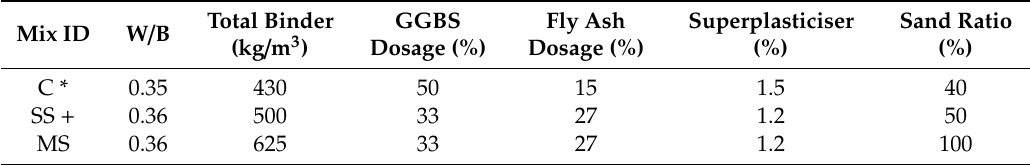
Table 1. Mix proportions of concrete and